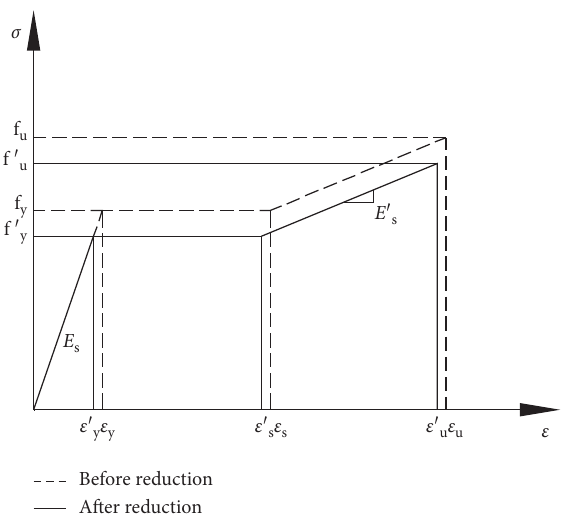
Figure 10: Constitutive relations of connected steels before and after reduction (note: the superscript “ ′ ” in the letter denotes “after reduction”; f u denotes ultimate strength, f y denotes yield strength, ε s denotes starting point of reinforced strain, ε u denotes ultimate